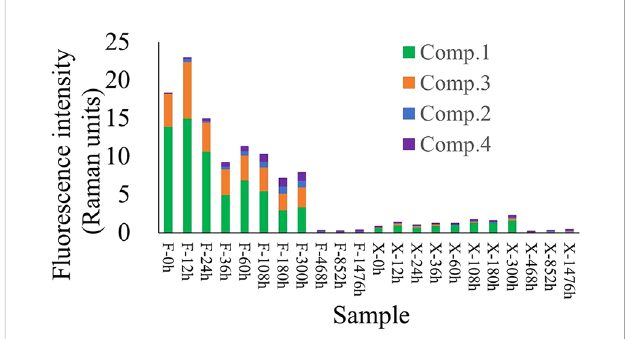
FIGURE 4 Variation in fl uorescent active components over time during the degradation of U. prolifera . The abscissa represents the samples at different times